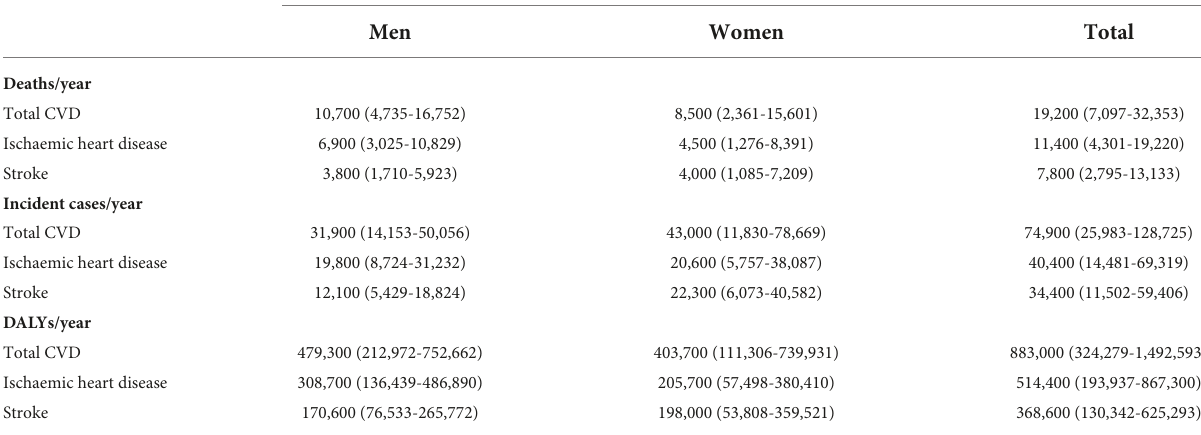
TABLE 2 Estimated burden of ultra-processed foods on cardiovascular disease events among Brazilian adults from 30 to 69 years of age (deaths, incident cases and DALYs) in 2019. Metric and